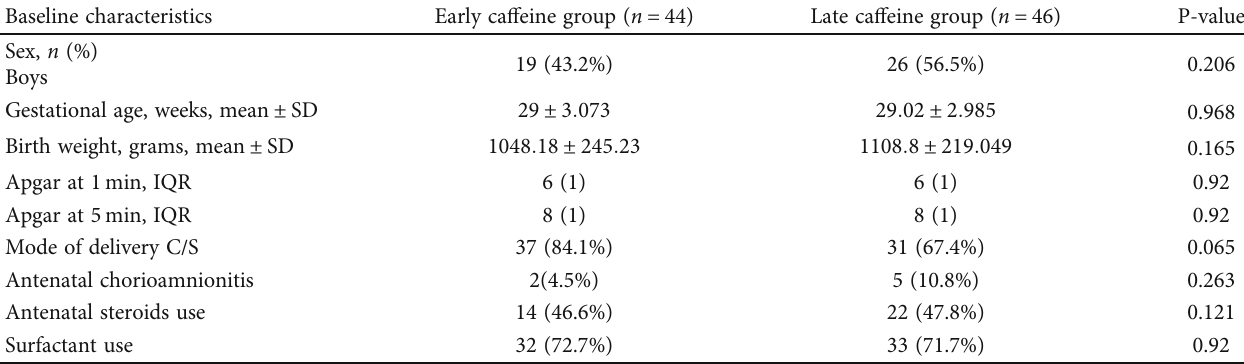
Table 1: Baseline characteristics of early and late ca ff eine